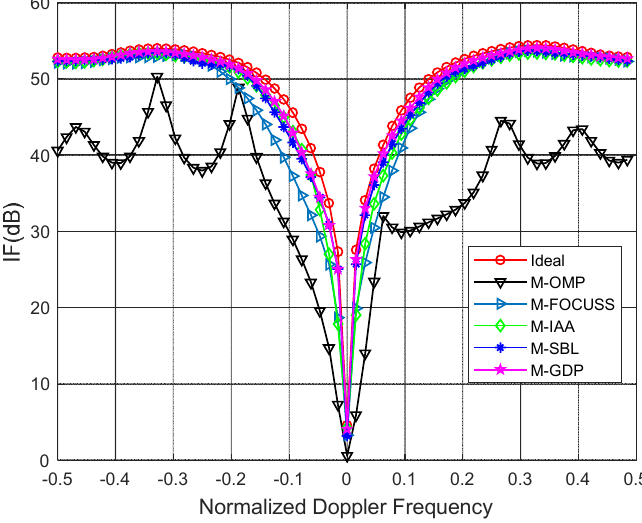
Figure 2. IF against normalized Doppler frequency under ideal condition.